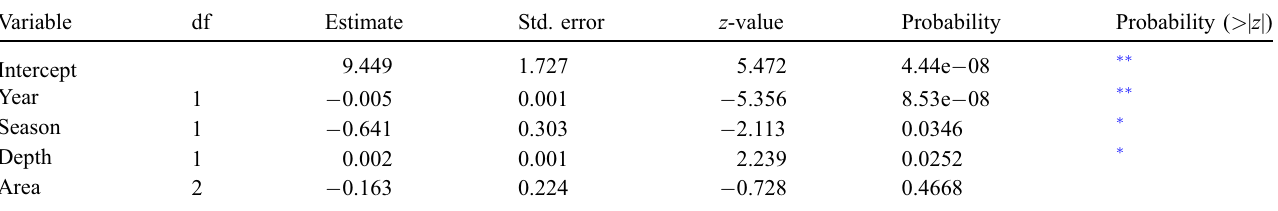
Table 2. Summary of the generalised mixed model results for blue whiting proportion of females on the Portuguese shelf. df – degrees of freedom; std. error – standard error.